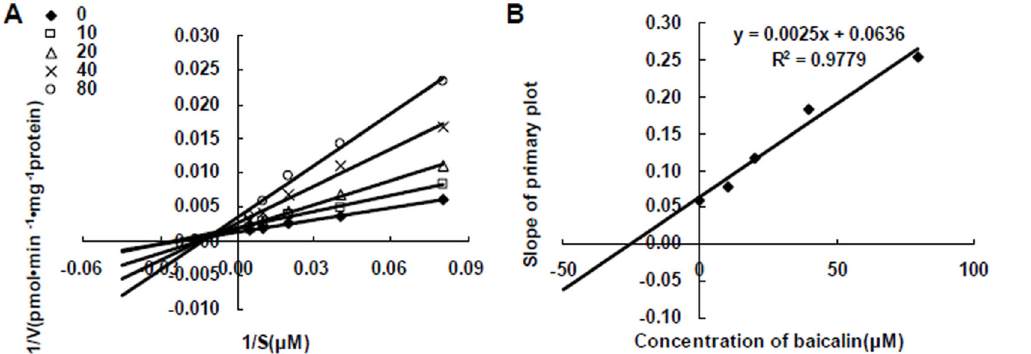
Figure 1. Inhibition of CYP1A2 activity by baicalin in pooled human liver microsomes. (A) Lineweaver-Burk plots of the effect of baicalin on formation of acetaminophen in pooled human liver microsomes. Reactions were performed in the presence of phenacetin (12.5, 25, 50, 100, 200 m M) and various concentrations of baicalin (0, 10, 20, 40, 80 m M) in the microsome (0.3 mg/mL). (B) Secondary plot of the slopes from the Lineweaver–Burk plots verse baicalin concentrations. doi:10.1371/journal.pone.0089752.g001 PLOS ONE |